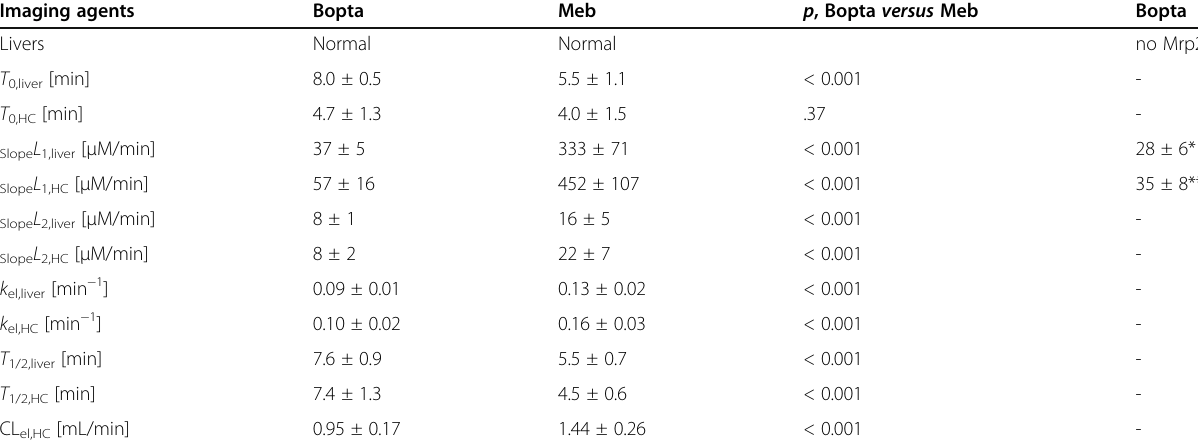
Bopta and Meb accumulation in normal livers and hepatocytes fitted nonlinear regressions described by two lines L 1 and L 2 intersecting at T 0 or time when bile secretion started to impact the accumulation profile. During decay, liver and hepatocyte concentrations fitted a one-phase decay described by k el and T 1/2 . CL el,HC was calculated by k el · V HC . Statistics between normal livers and livers lacking Mrp2 (column 2 versus column 5) are p < 0.010 (*) and p < 0.001 (**). CL el , HC Elimination clearance from hepatocytes, k el Elimination constant rate, HC Hepatocytes, T 1/2 Half-life of elimination, V HC Hepatocyte